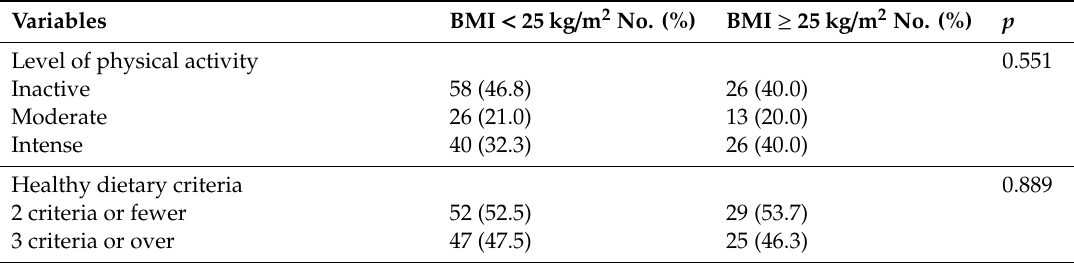
Table 2. Level of physical activity, healthy dietary criteria, and socio-demographic characteristics of the students that presented a BMI within normal limits vs. a high BMI.